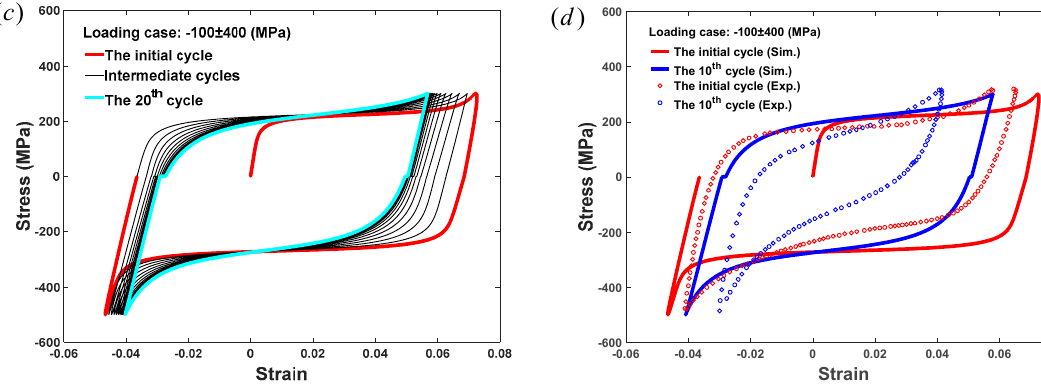
Figure 5. Model predictions and experimental verifications of the proposed constitutive model used for shape-memory SMAs. ( a ) Model prediction under loading with stress range of 0 ± 500 MPa ; ( b ) Experimental verification under loading with stress range of 0 ± 500 MPa ; ( c ) Model prediction under loading with stress range of − 100 ± 400 MPa ; and ( d ) Experimental verification under loading with stress range of − 100 ± 400 MPa. (“Sim.” represents the simulation results and “Exp.” represents the experimental results).